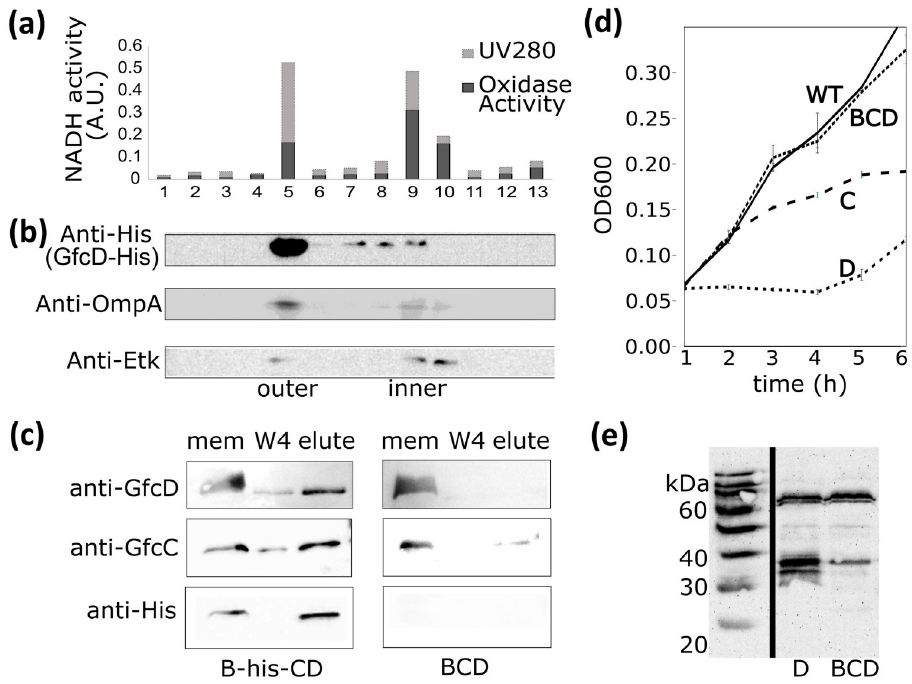
Fig 3. Localization and protein interactions of GfcD. GfcD-6His dominantly localizes to outer membrane fractions. (a) NADH oxidase activity was measured for each fraction and (b) fractions were blotted for known markers of the inner (Etk) and outer membrane (OmpA) and the His-tag of GfcD to define inner and outer membrane fractions (original blot scans in S1 Raw images). (c) GfcB-His6, GfcC, and GfcD were co-expressed in EPEC cells and pulled- down with NiNTA beads. GfcC and GfcD proteins were detected on Western blots. Right , Absence of a His-tagged GfcB results in loss of pull-down of GfcC or GfcD. Abbreviations: Mem : membrane fraction; W4 : fourth wash of pull- down, Elute: pull-down product. (d) Over-expressing GfcC or GfcD alone inhibits cell growth of EPEC; no inhibition is observed during co-expression of GfcB, GfcC, and GfcD ( BCD ). (e) Anti-GfcD blot comparing levels of GfcD when expressed alone or with GfcB and GfcC. Full length GfcD is at 60 kDa on this blot. GfcD rapidly undergoes proteolysis when expressed alone.